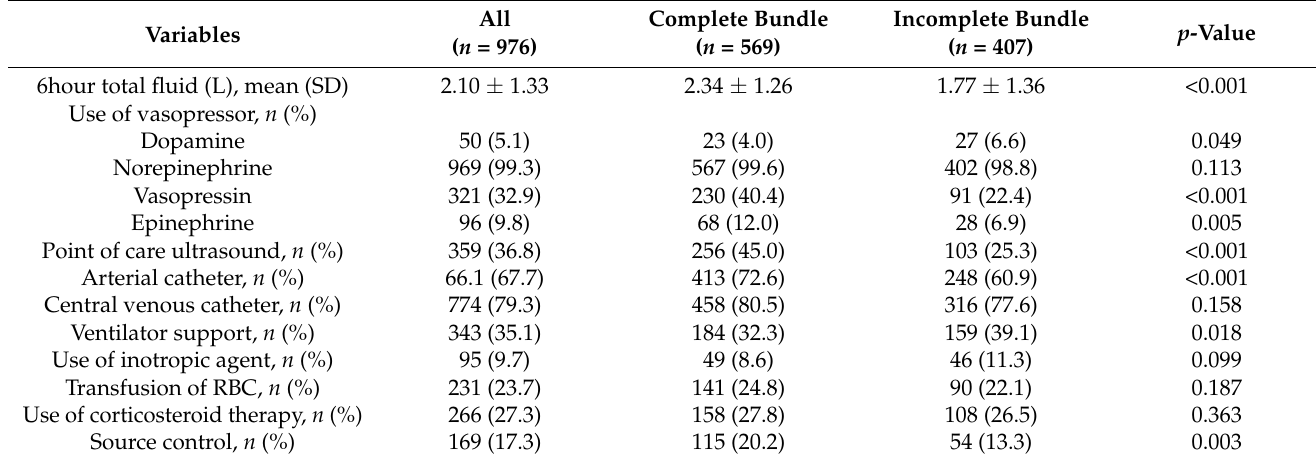
Table 2. Management of shock over the initial 6 h ( n = 976).